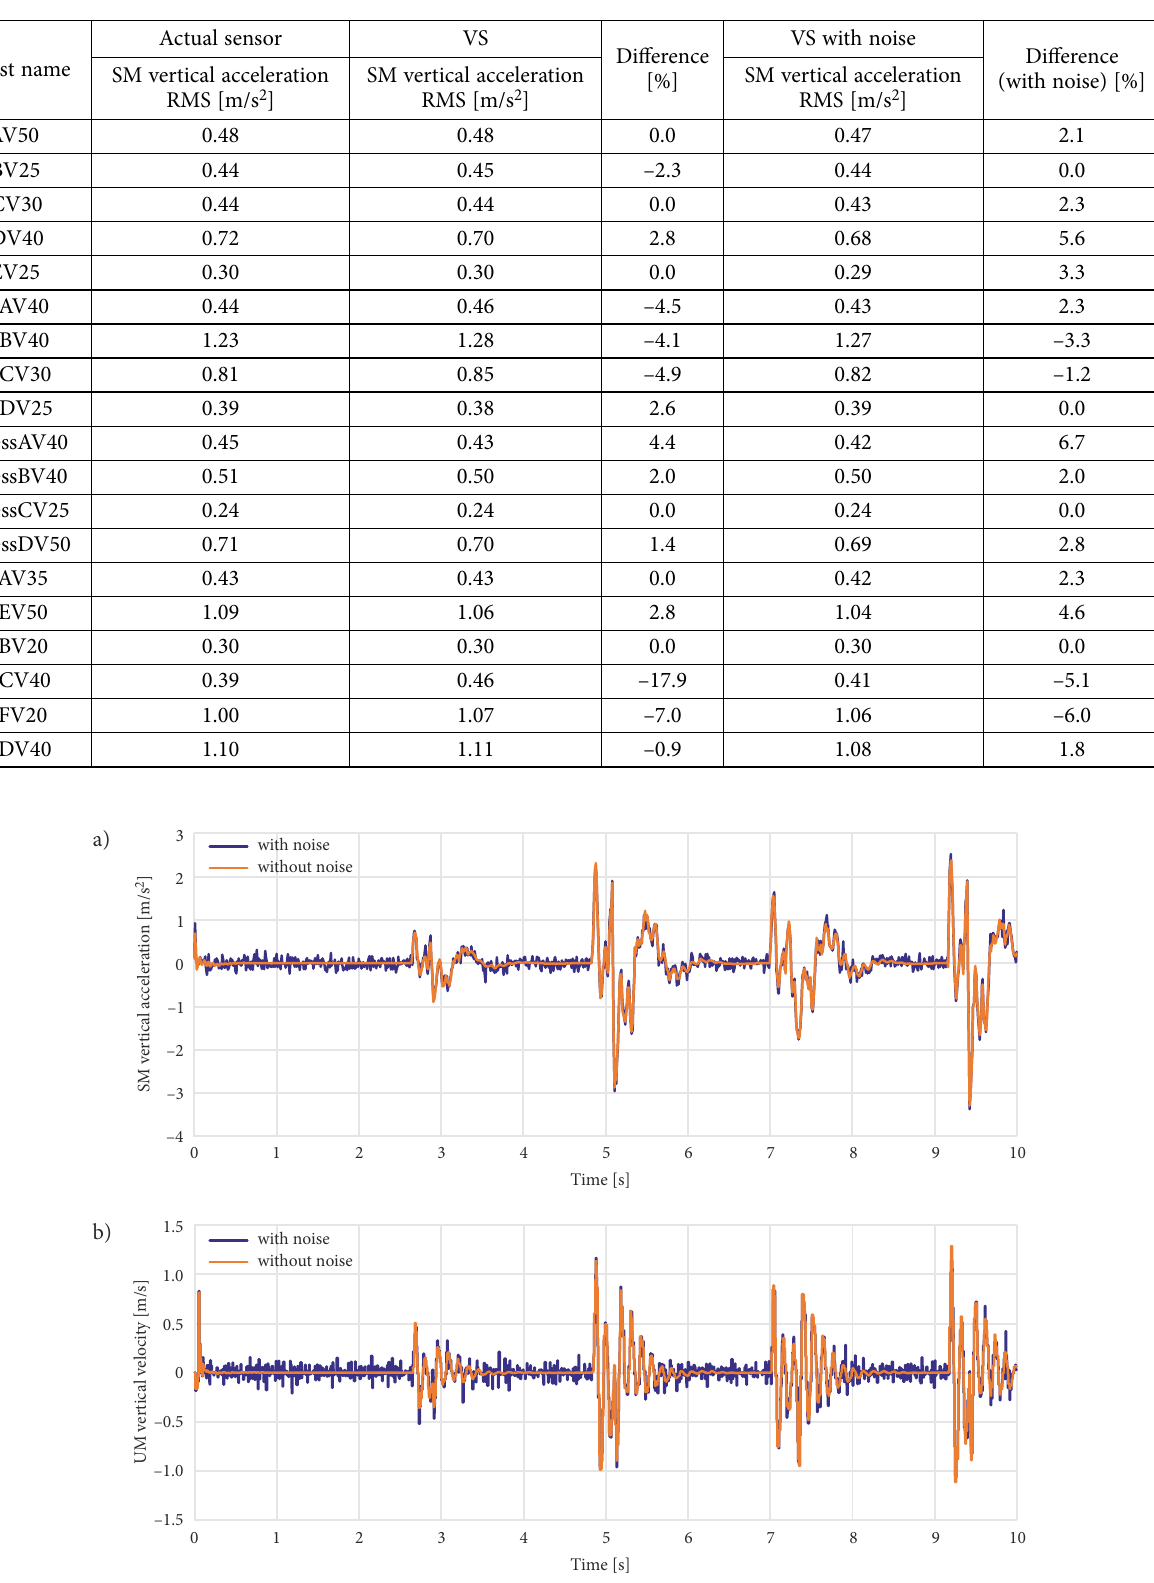
Figure 6. VS performance with noise: a – input with and without noise; b – output with and without